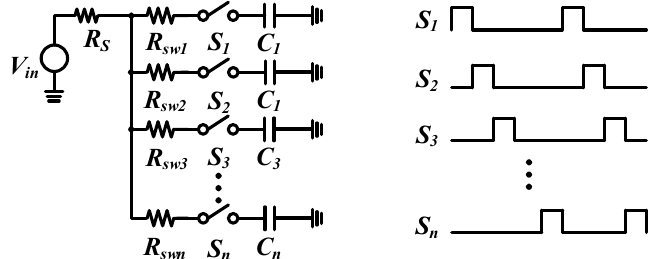
Figure 1. NPSC network with multiphase non-overlapped